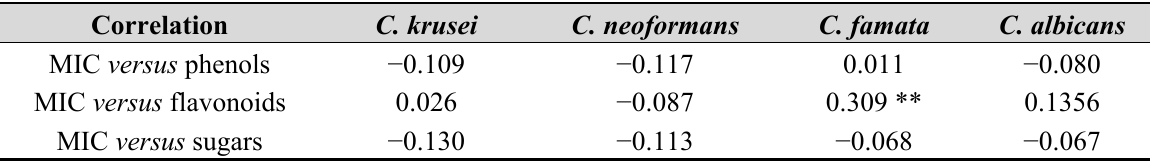
Table 4. Pearson’s correlation coefficients between MIC and phenols, between MIC and flavonoids, and between MIC and sugars for the yeasts